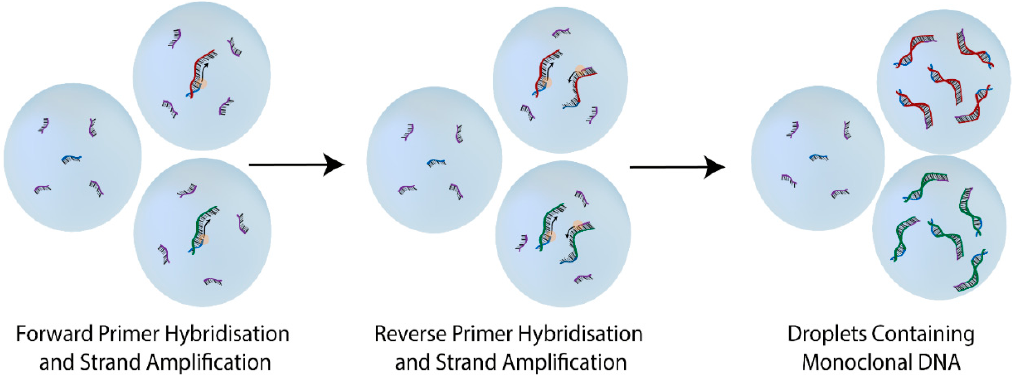
Figure 3. Emulsion Polymerase Chain Reaction. Droplets are formed containing PCR reagents, including forward primers (Blue strands) and reverse primers (Purple Strands) and template strands (Red and Green strands). Concentrations are adjusted to ensure that each reacting droplet contains one unique template strand according to Poisson statistics and results in a high proportion of droplets without template strands. Within droplets containing all necessary PCR reagents, DNA amplification occurs. PCR amplification is cycled until the droplets contain an optimal concentration of double stranded monoclonal DNA.